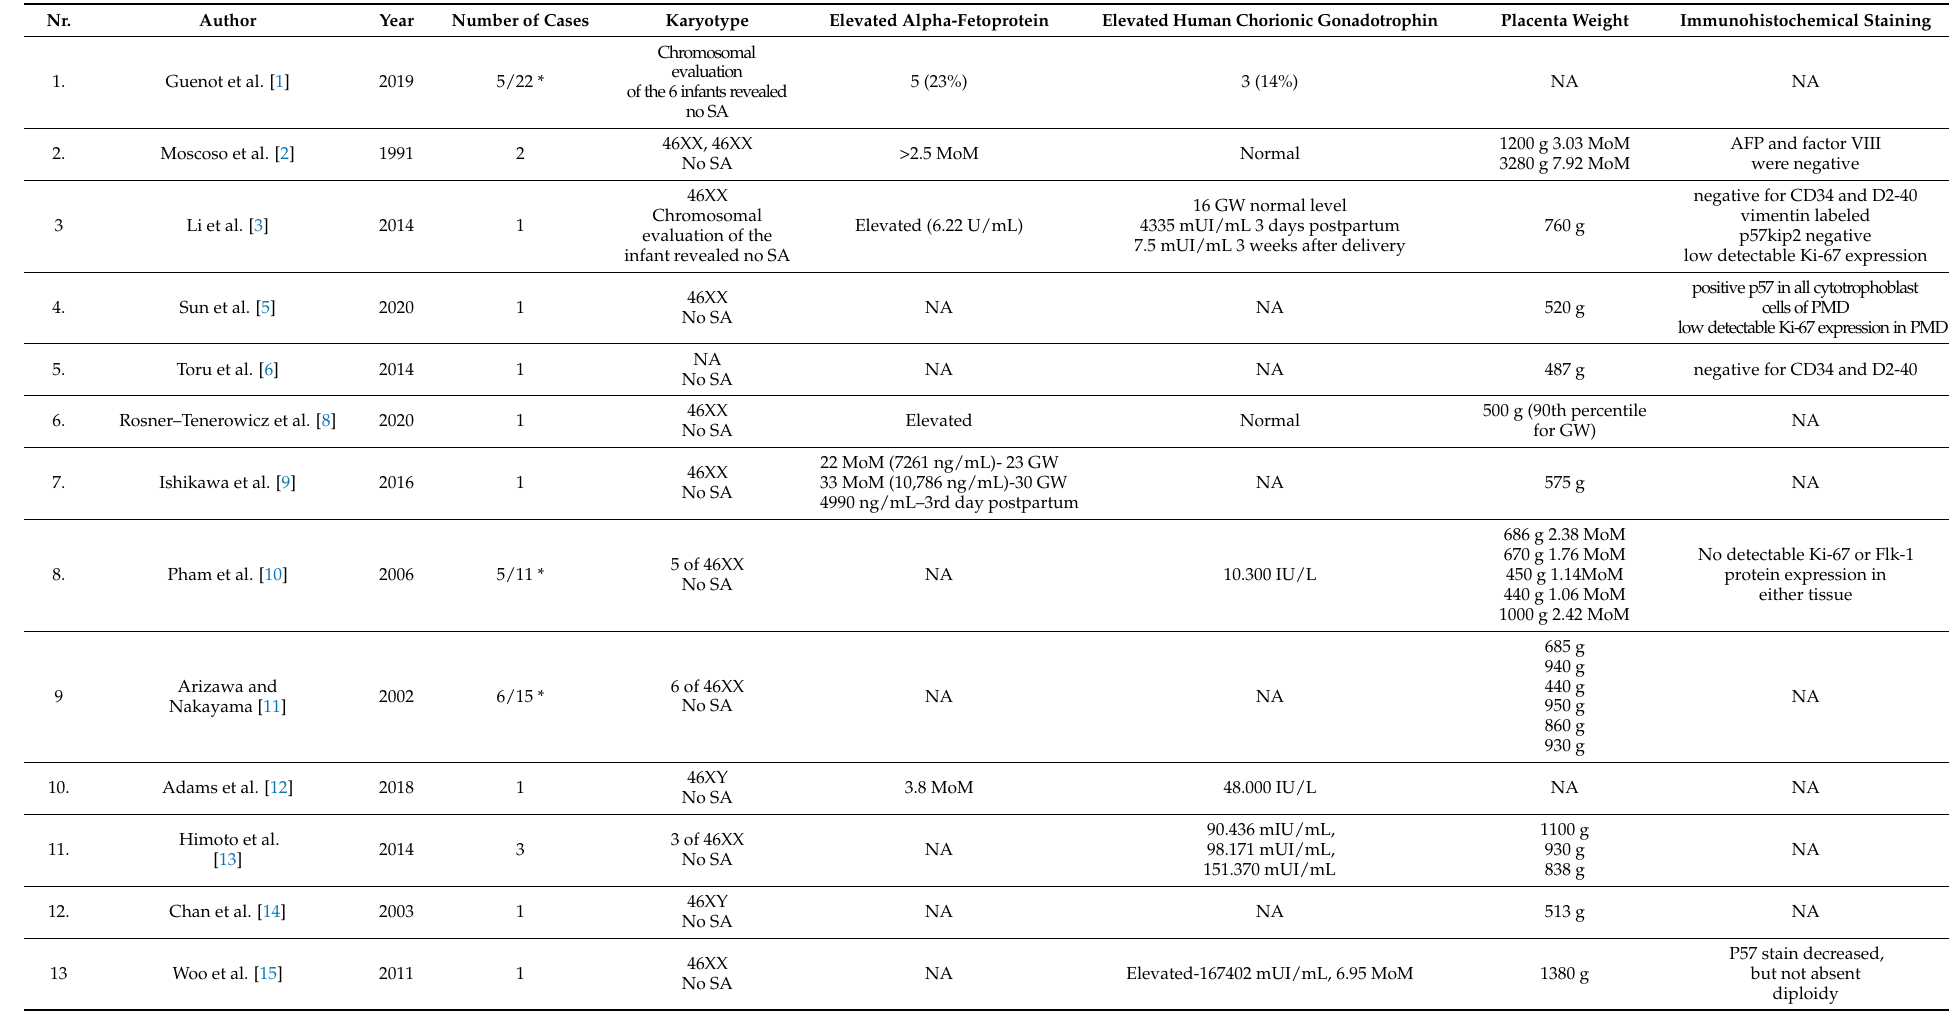
Table 1. Literature review for case reports and case series of PMD; placental and biochemical